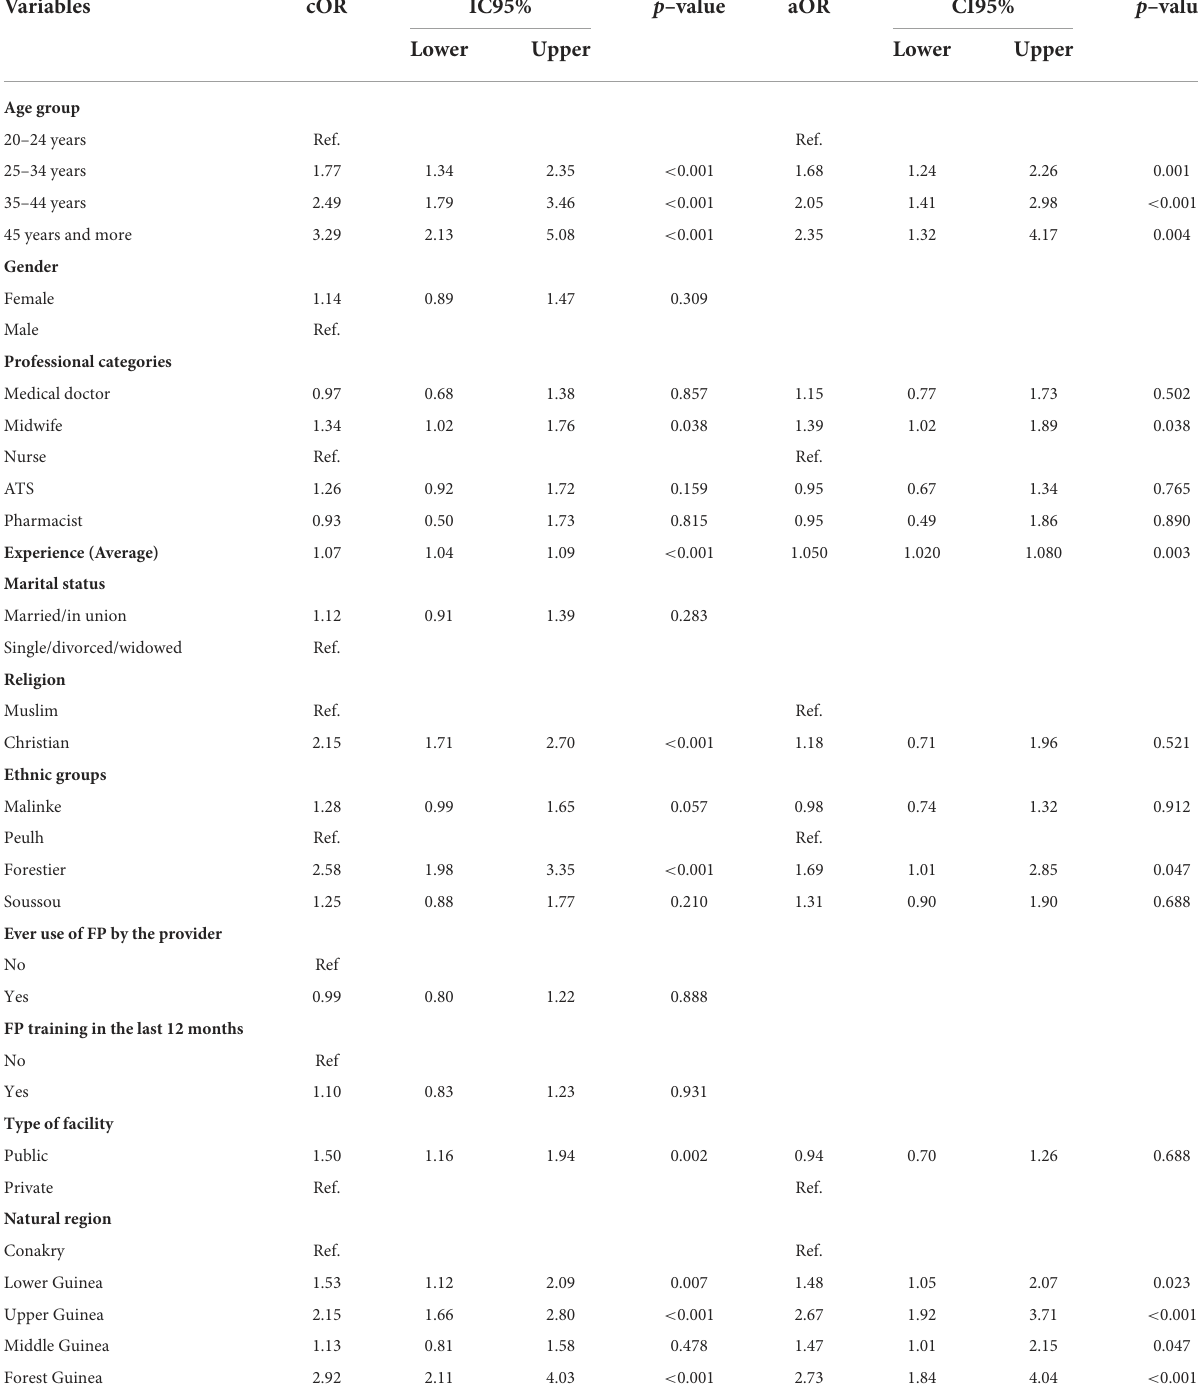
TABLE 5 Factors associated with provider attitudes toward contraceptive use among adolescents and youth, Guinea, January-March 2021 ( N = 1,707).